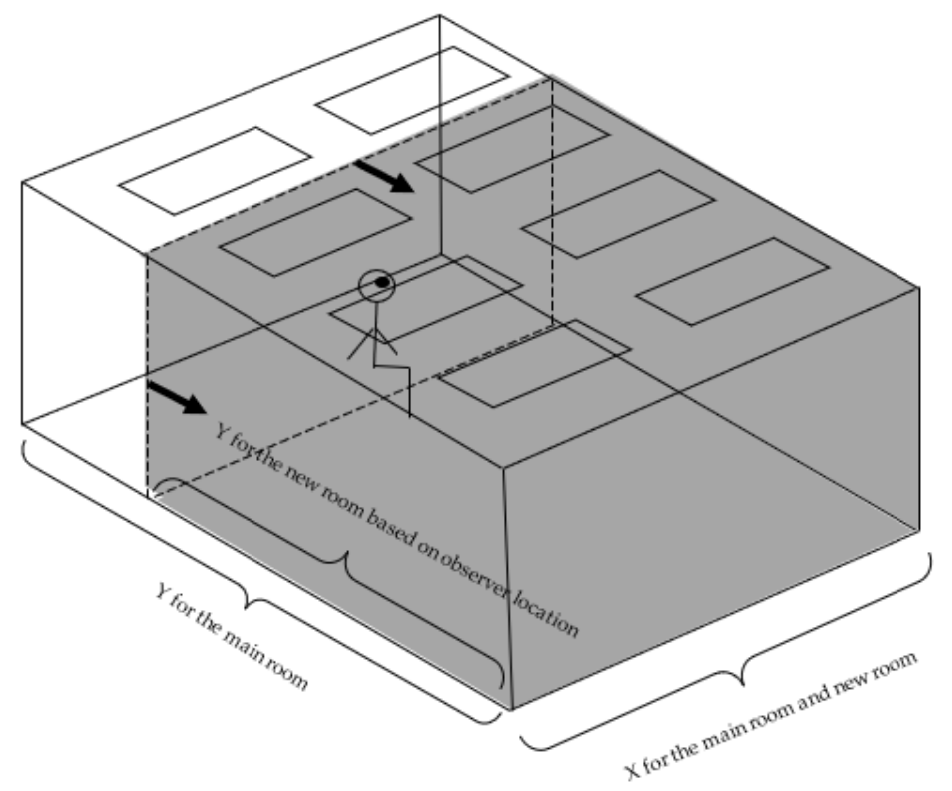
Figure 3. Illustration of the part of the main room (in grey color) which is used as a new room with different dimensions for UGR calculation in the proposed method.